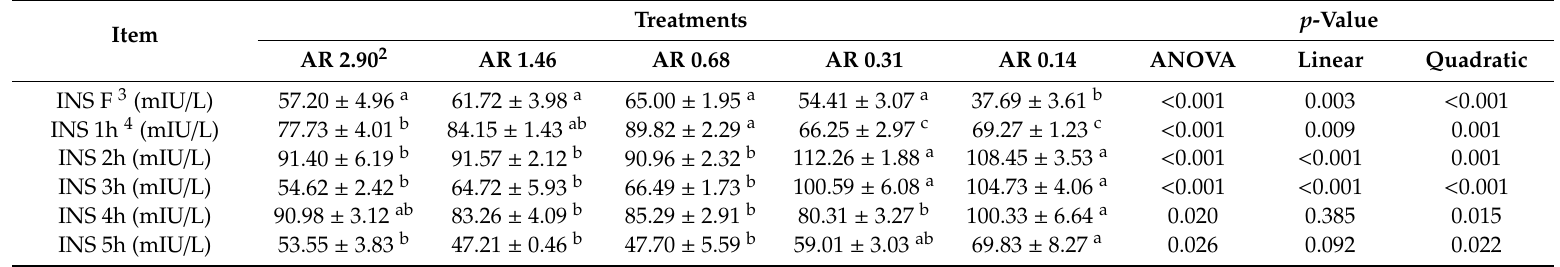
Table 6. E ff ects of dietary starch structure on serum insulin in weaned piglets (mean values with their standard errors) 1